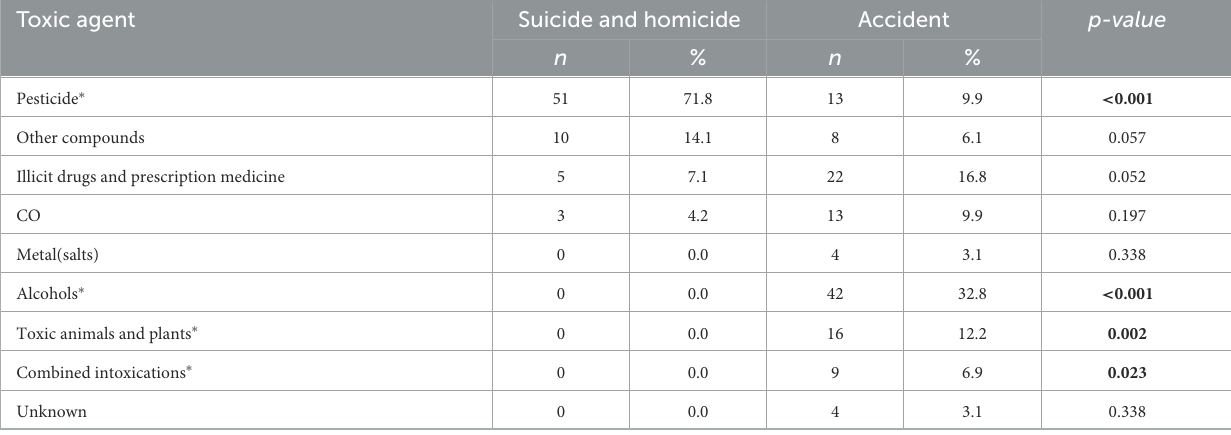
TABLE 6 The motivation for intoxication deaths in 1999–2021.